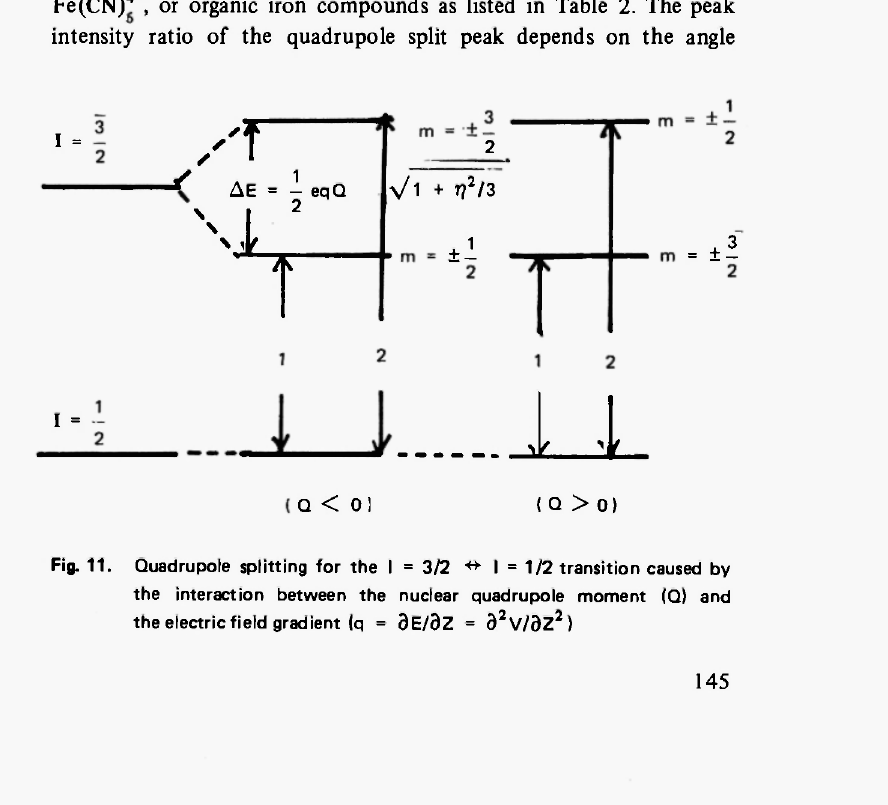
Quadrupole splitting for the I = 3/2 ** I = 1/2 transition caused by the interaction between the nuclear quadrupole moment (Q) and the electric field gradient (q =